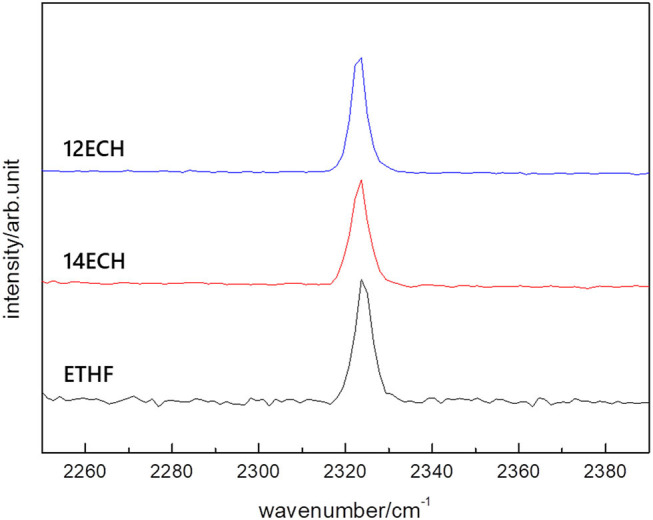
Raman spectra of the LGM + N2 hydrates measured at 123 K.